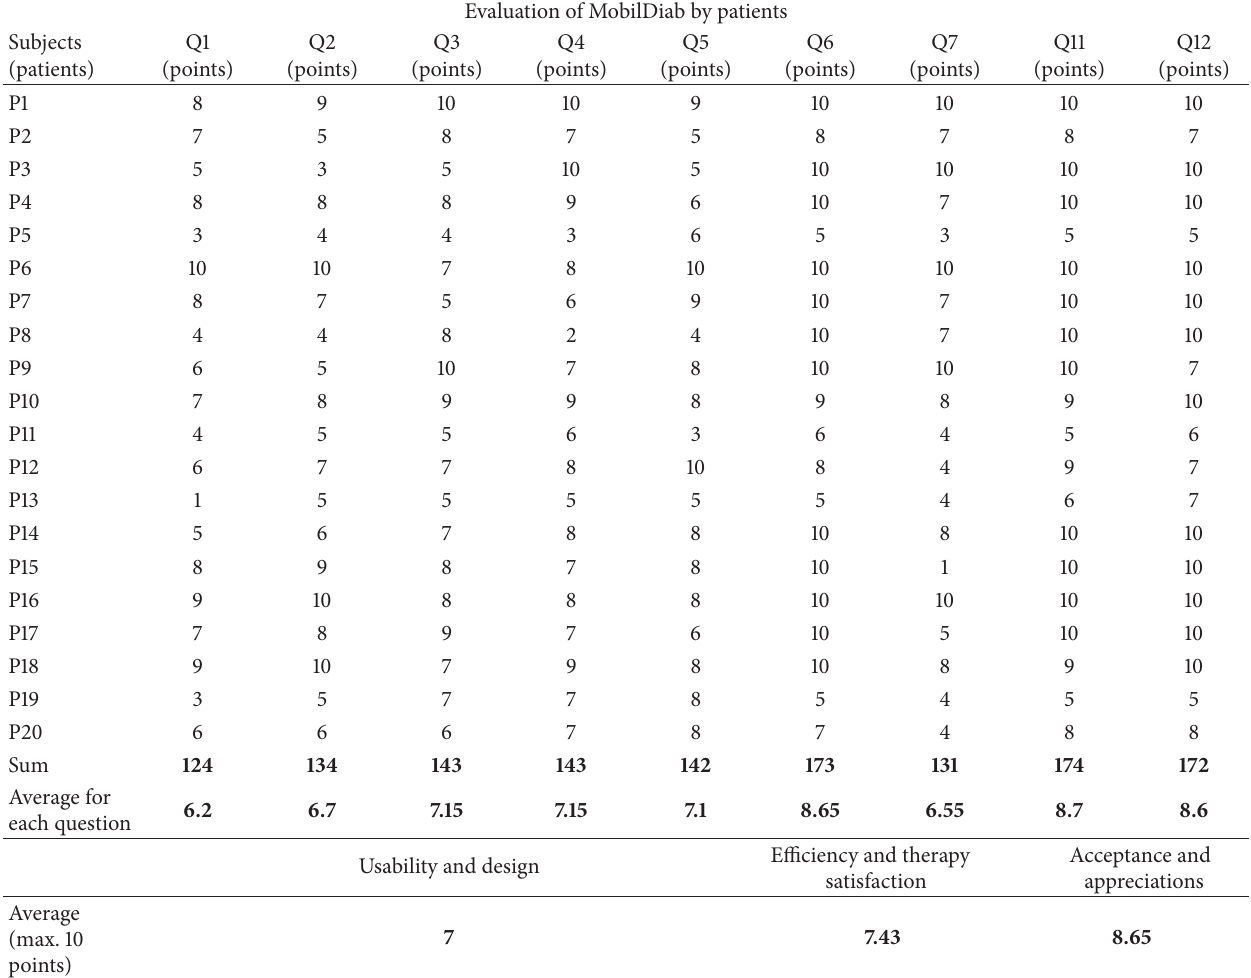
Table 1: Evaluation of usability, efficiency, and acceptance of Mobil Diab by patients. Evaluation of MobilDiab by patients